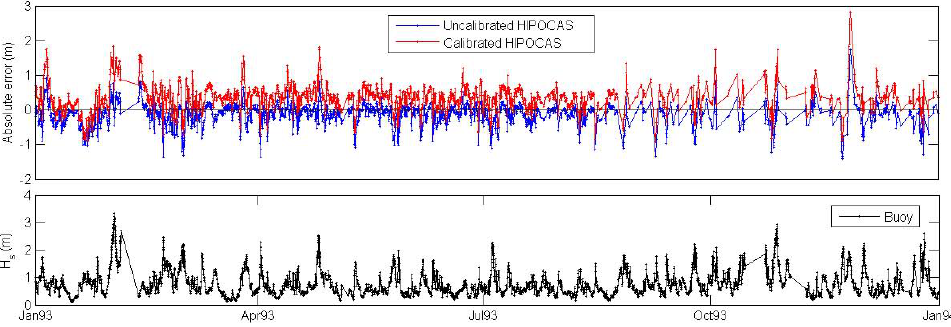
Fig. 2. Upper panel: differences between hindcast (calibrated and uncalibrated) data and buoy measurements during 1993 in Tortosa. Lower panel: H s buoy time series (Tortosa buoy coordinates: 40 ◦ 43.29 0 N, 00 ◦ 58.89 0 E, from XIOM network).